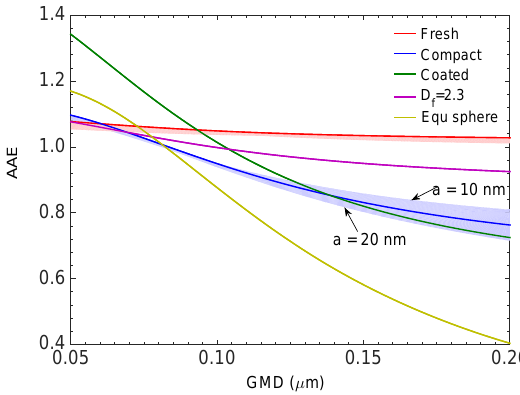
Figure 6. AAEs of the fresh, compact and coated BC as a function of the volume equivalent GMD of the BC particles (or BC core for coated